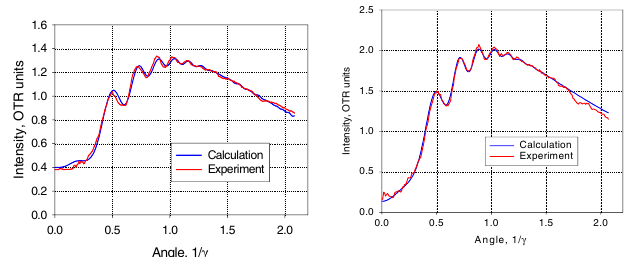
FIG. 15. (Color) ODTR (left) and an OTR (right) interference pattern for ATF Tune 1 with overlay of horizontal sectors used to average the fringe